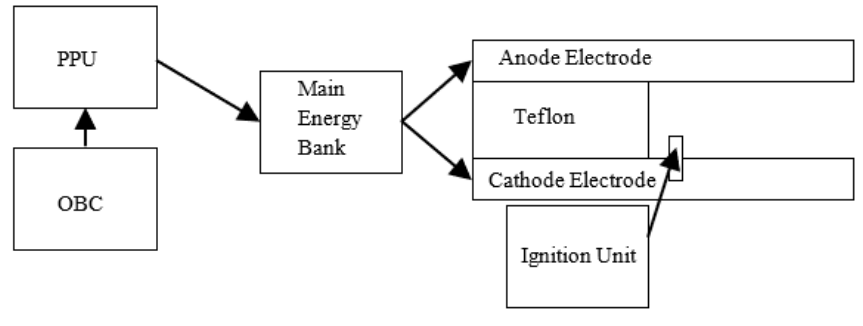
Figure 1. Basic PPT schematic.